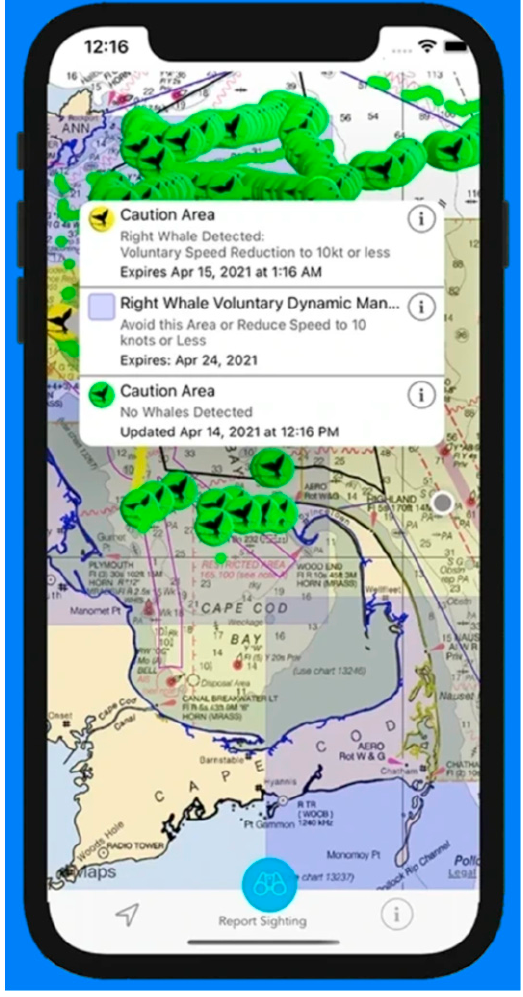
Figure 12. The Whale Alert citizen science app used to report and display whale sightings in an effort to reduce the risk of vessel strikes (https://www.whalealert.org/ (accessed on 23 December 2022)).